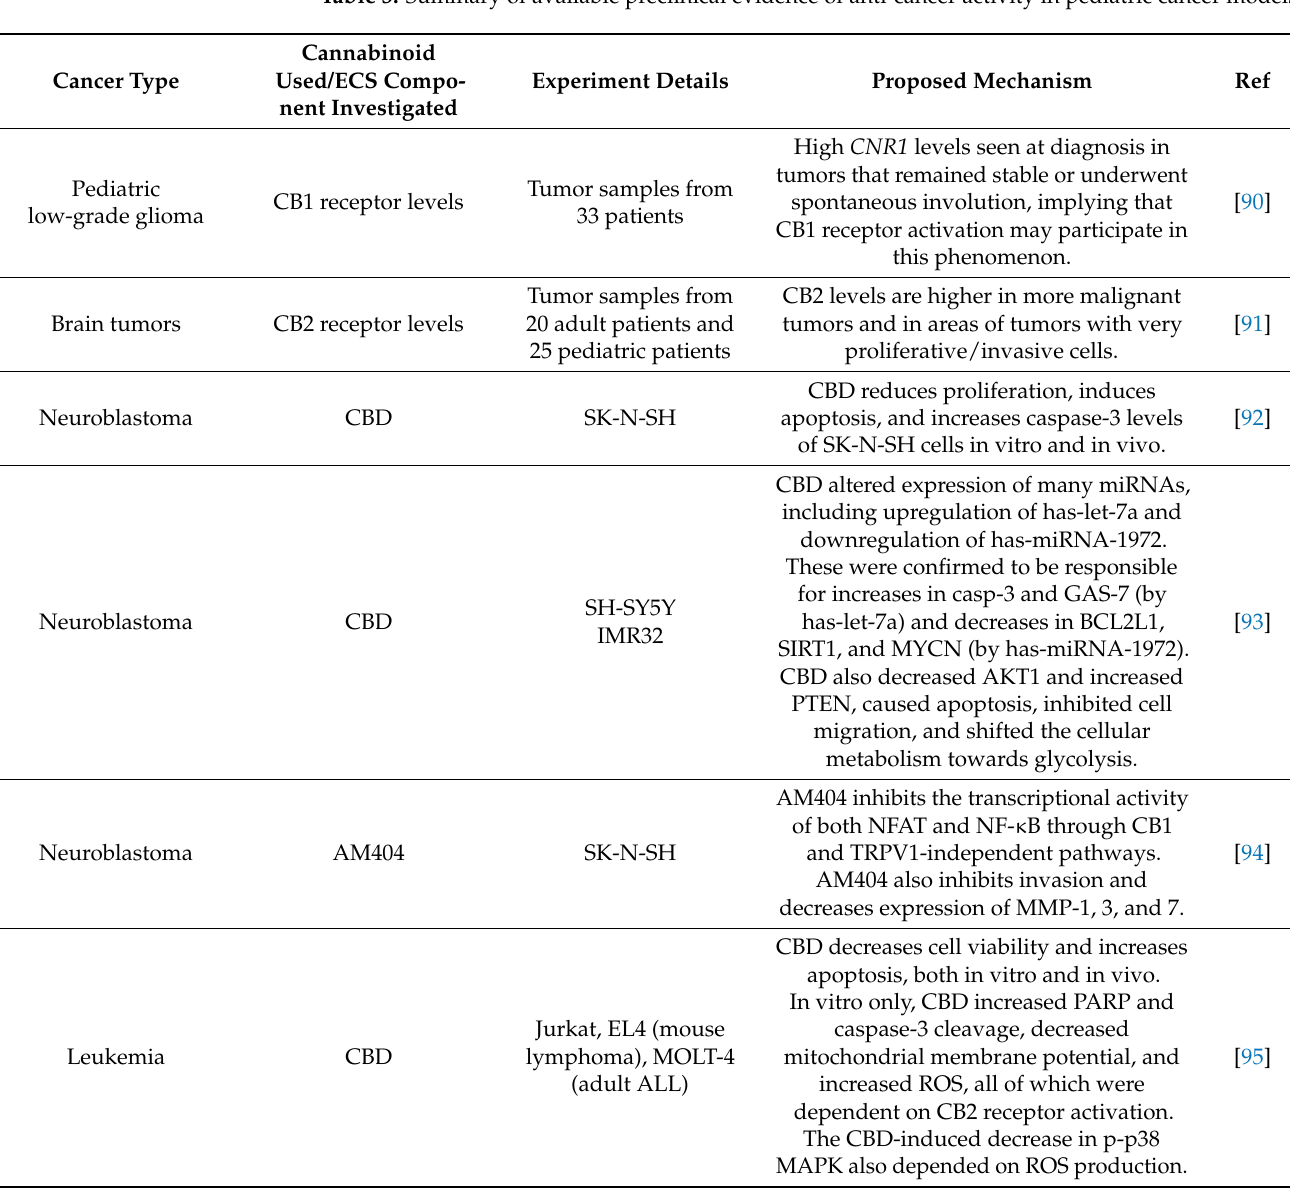
Table 3. Summary of available preclinical evidence of anti-cancer activity in pediatric cancer